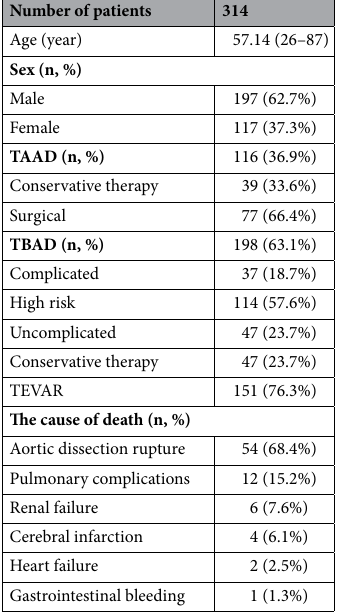
Table 1. General characteristics of AAD patients. AAD, acute aortic dissection; TAAD,Stanford type A aortic dissection; TBAD, Stanford type B aortic dissection; TEVAR, thoracic endovascular aortic